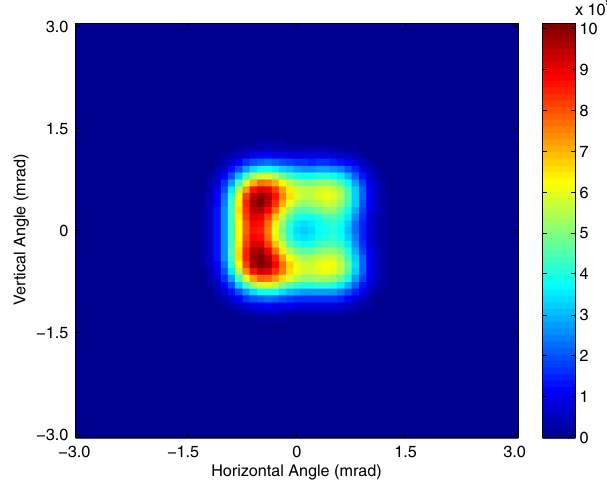
FIG. 3. Result of simulation of a single shot diffraction pattern for the same conditions as given in Fig. 2. The intensity is photons = rad 2